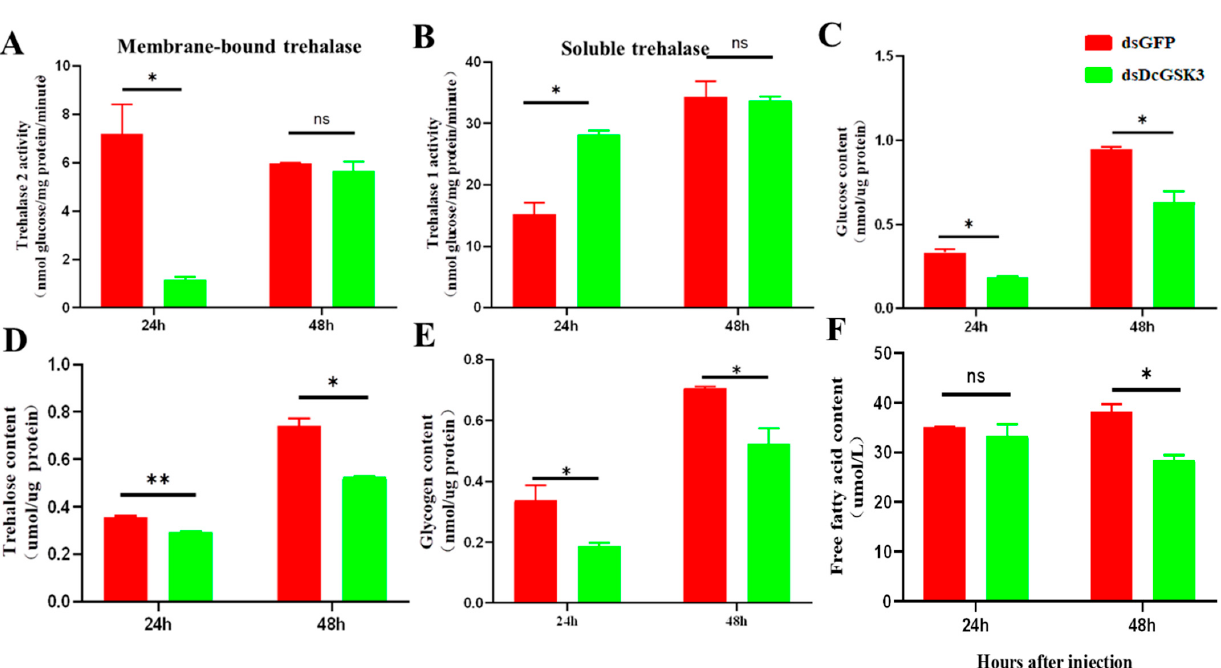
Figure 6. Effect of silencing DcGSK3 on the trehalase activity, glucose content, trehalose content, glycogen content and free fatty acid content at 24 h and 48 h. Membrane-bound trehalase activity ( A ), soluble trehalase activity ( B ), glucose content ( C ), trehalose content, ( D ) glycogen content ( E ) and free fatty acid content ( F ) at 24 h and 48 h. Each experiment contained three biological replicates. The significant differences are indicated by * ( p < 0.05) or ** ( p < 0.01). The “ns” indicated no significant differences.